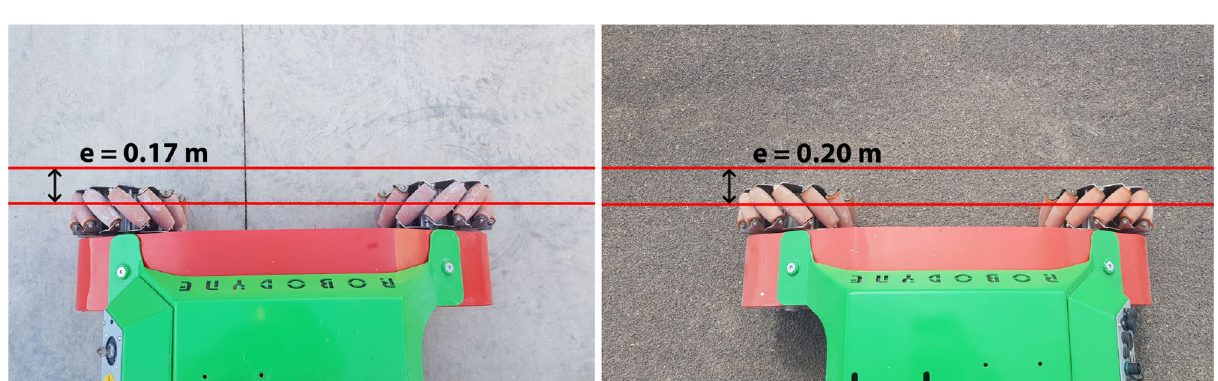
Figure 17. Final angle deviation with PID on straight trajectory on concrete, on the left, and the angle deviation with PID for asphalt, on the right.